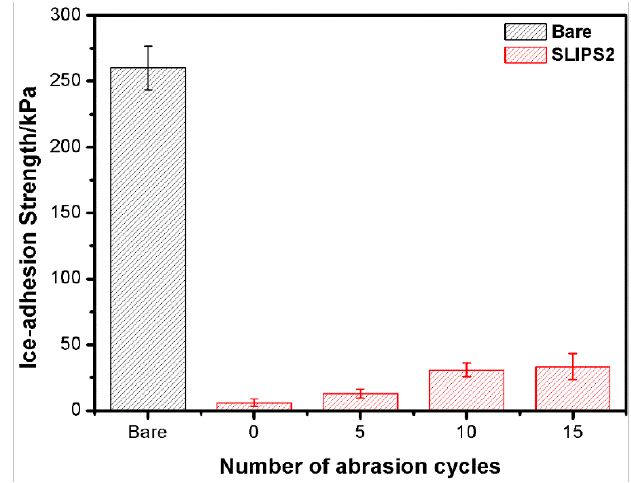
Figure 8. Variation of ice-adhesion strength of SLIPS2 after a number of abrasion cycles.